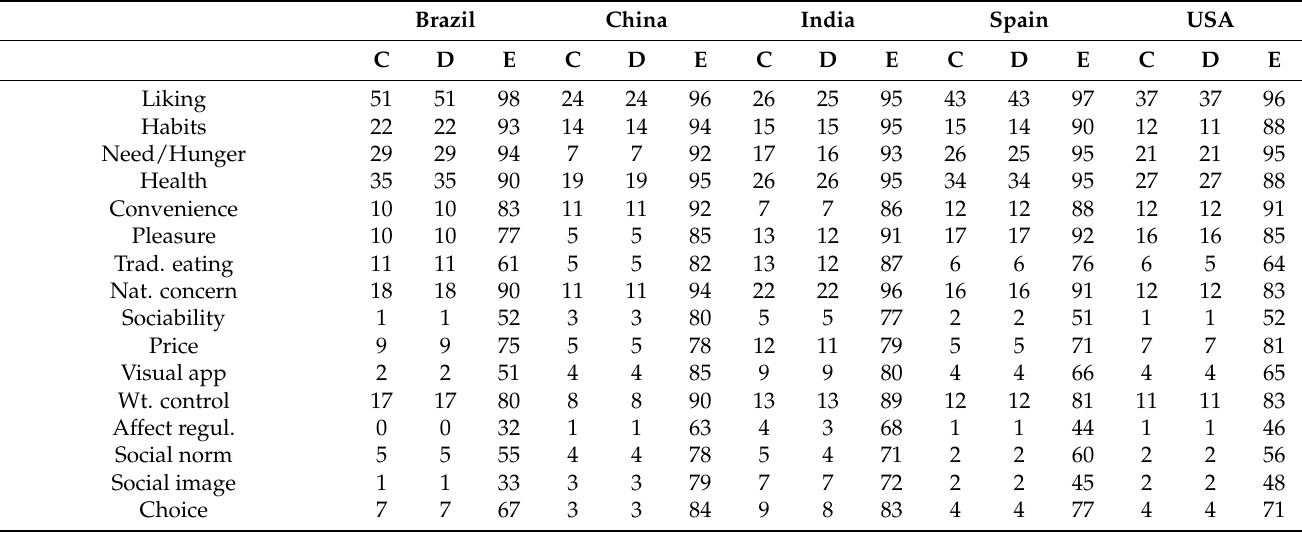
Table A3. Percentage of “apply” responses for CATA, RATA, and RATING for all five countries for the respective fruits and vegetables.